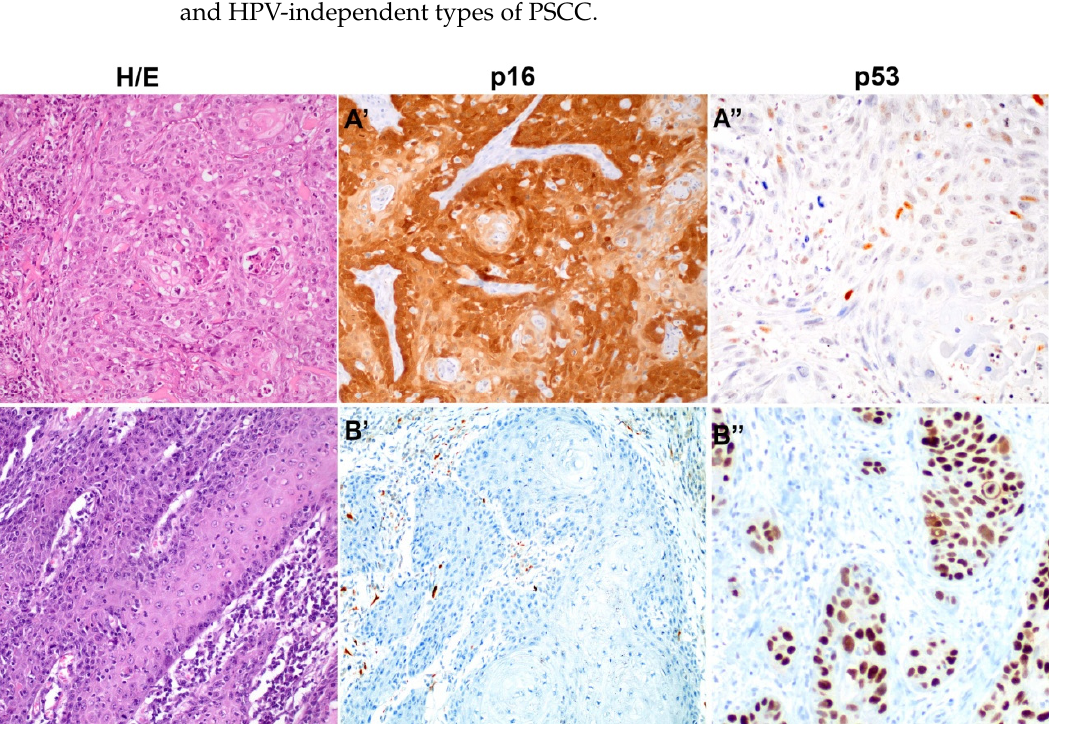
Figure 1. Histological and immunohistochemical features of a representative example of Human Papillomavirus (HPV)-associated ( A , A ′ , A ″ ) and HPV-independent ( B , B ′ , B ″ ) penile squamous cell carcinoma (PSCC). ( A , B , hematoxylin and eosin, 200×), p16 ( A ′ , B ′ ) and p53 ( A ″ , B ″ ), HPV-associated PSCC, the most frequent type in Mozambique, is characterized by diffuse positive p16 staining and scattered irregular nuclear positivity for p53. HPV-independent PSCC, the most frequent type in Spain, is characterized by keratinizing histology, negative p16 staining and marked overexpression of p53.